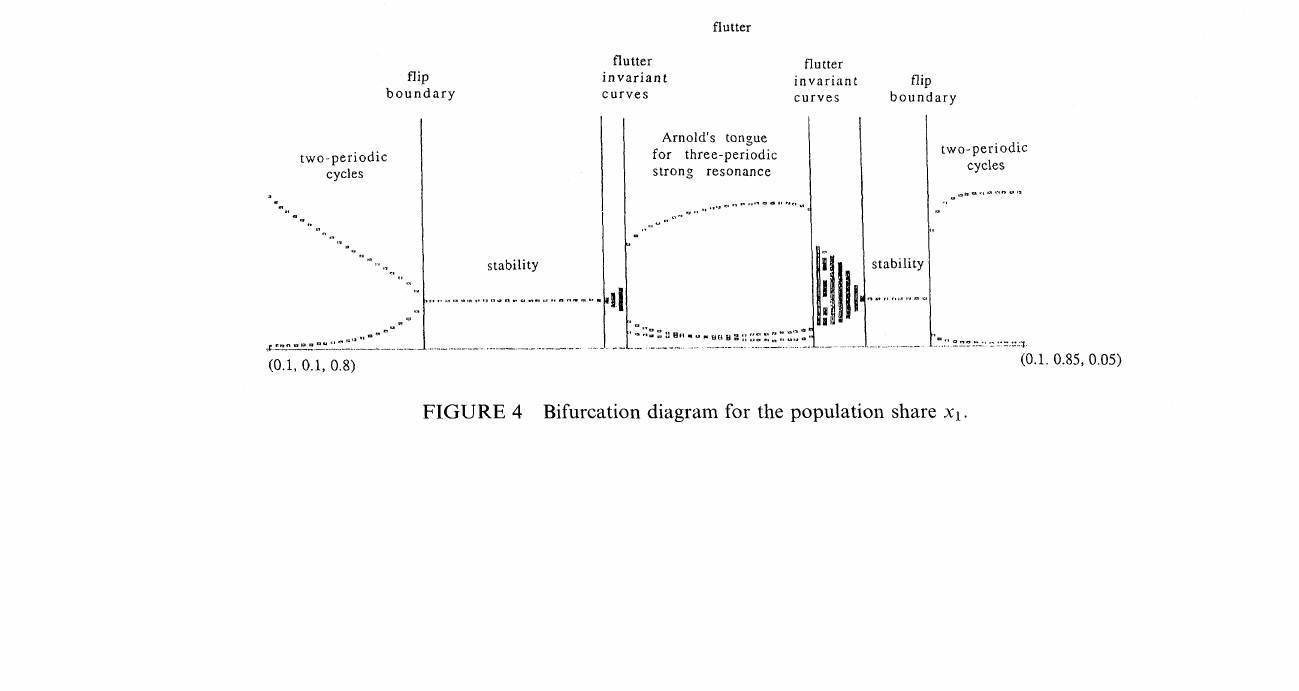
FIGURE 4 Bifurcation diagram for the population share